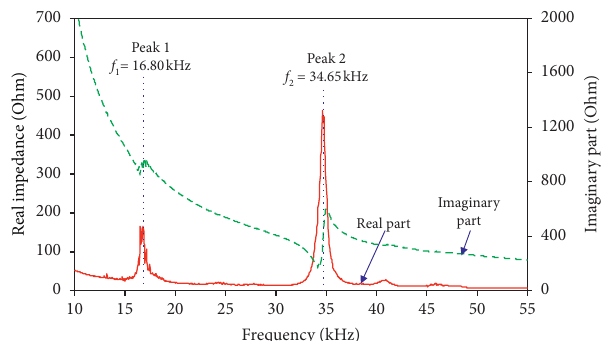
Figure 6: Experimental EMI